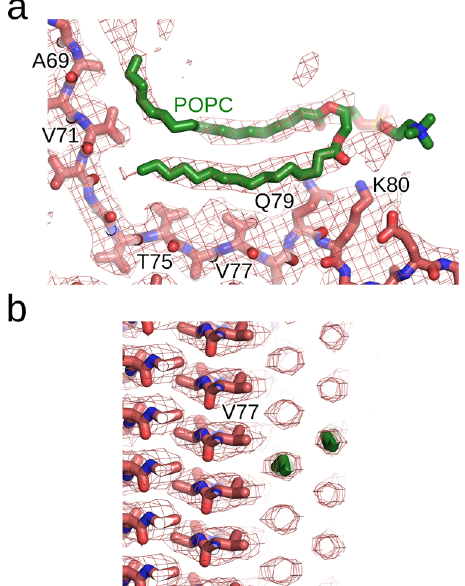
Fig. 5 | A lipid- fi bril binding-mode model. One POPC molecule(green sticks) was modeled into the sharpened map ofL1Cand isshown in a viewalong the fi bril axis ( a ) and perpendicular to the fi bril axis ( b